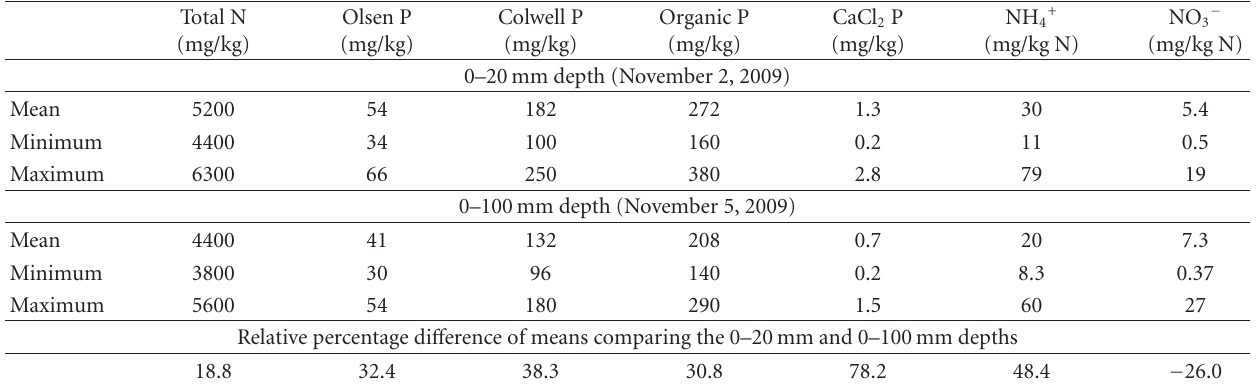
Table 1: Initial soil properties two weeks prior to ploughing (November 2 and 5,